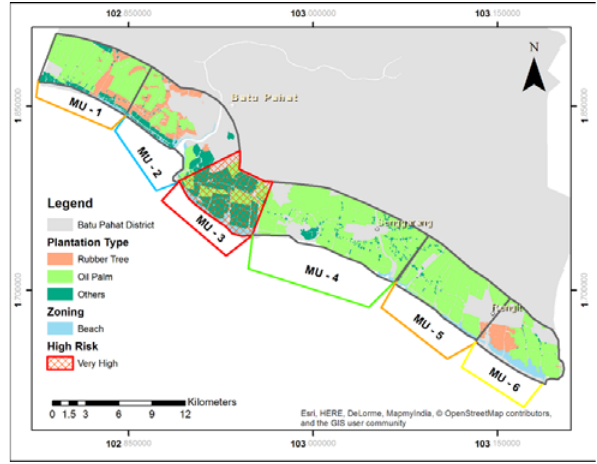
Figure 18. CVI Map for Very High Vulnerability